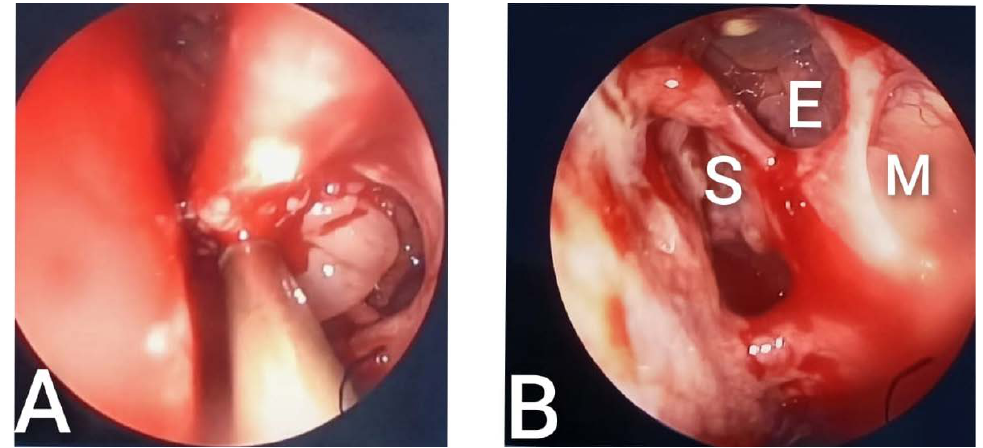
Figure 3. Intraoperative view: ( A ) part of tumor occupying left maxilar sinus ( B ) sphenoidal (S), posterior ethmoidal (E) and maxillary (M) sinuses free of tumor.